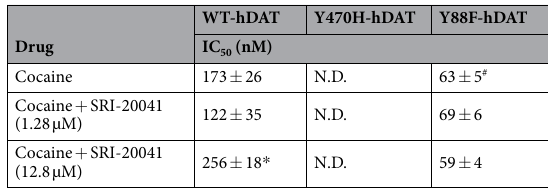
Table 2. Effects of SRI-20041 on Cocaine IC 50 of [ 3 H]WIN 35,428 binding in WT and mutated hDATs. Data are presented as mean ± S.E.M. of 4 independent experiments performed in duplicate. * p = 0.05 compared with the value of cocaine within WT (LSD post hoc test). # p < 0.05 compared with the value of cocaine from WT-hDAT (Student’s unpaired t test). N.D. indicated as non-detected.